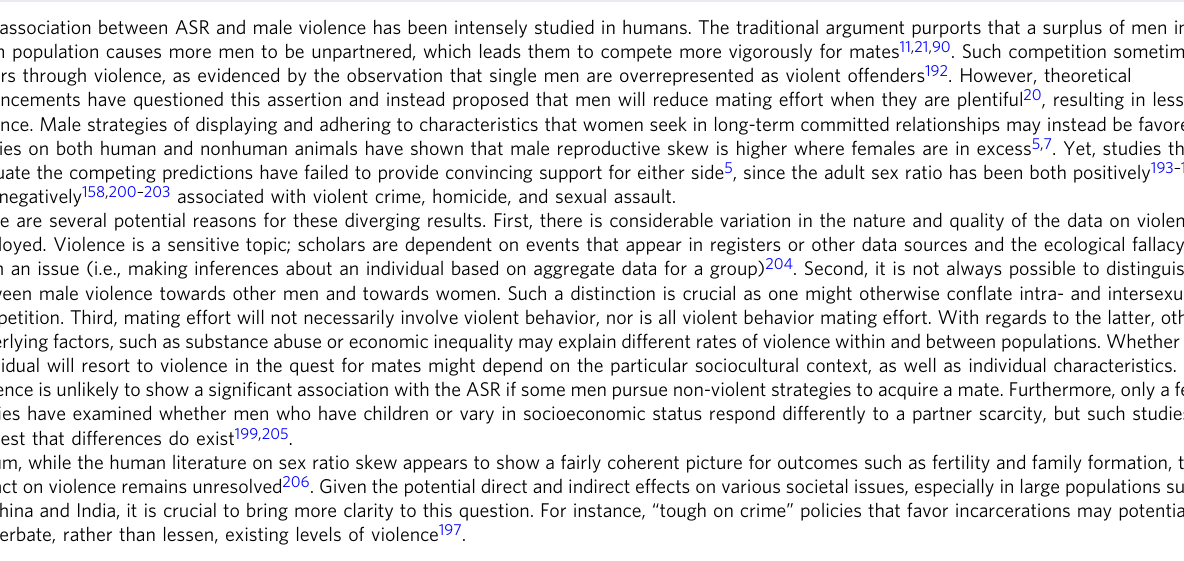
Box 5 Fig: Weighing the evidence. The empirical evidence for how adult sex ratios are linked to human mating behavior is mixed. However, on balance, studies from different contexts suggest that the prevalence of female-headed households and sexual risk-taking are higher under female-biased sex ratios, whereas marriage rates, fertility, and relationship stability are higher under male-biased sex ratios. For the outcome of male violence, the jury is still out as studies have demonstrated both positive and negative associations with ASR. Various factors, from data biases to lack of theoretical clarity, may be responsible for the contradicting patterns and need to be addressed in future